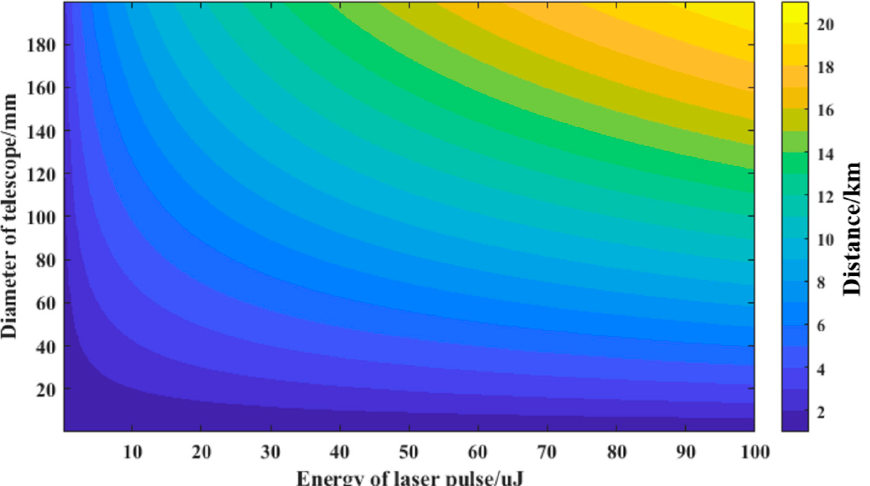
Figure 3. Maximum detection range map at different laser pulse energy and different Telescope diameter.